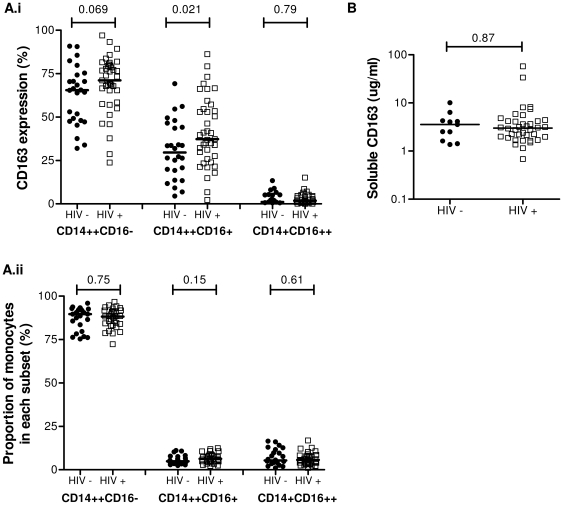
Membrane bound and soluble CD163 in monocyte subsets from HIV-1 infected donors.(A.i) CD163 expression on each monocyte subset was determined using a whole blood flow cytometric assay for HIV-1 uninfected donors (closed circles, n = 27) and infected donors (open squares, n = 38). Bars represent median values. (A.ii) The proportion of total monocytes in each of the three monocyte subsets was determined for each donor analysed in (A.i). The event count for that subset was divided by the sum of events in each subset. Bars represent median values. (B) Soluble CD163 in serum from 12 HIV uninfected donors, 38 HIV-1infected donors receiving antiretroviral therapy was determined by sandwich ELISA. Bars represent median values. P values were calculated using the non-parametric Mann Whitney U test.